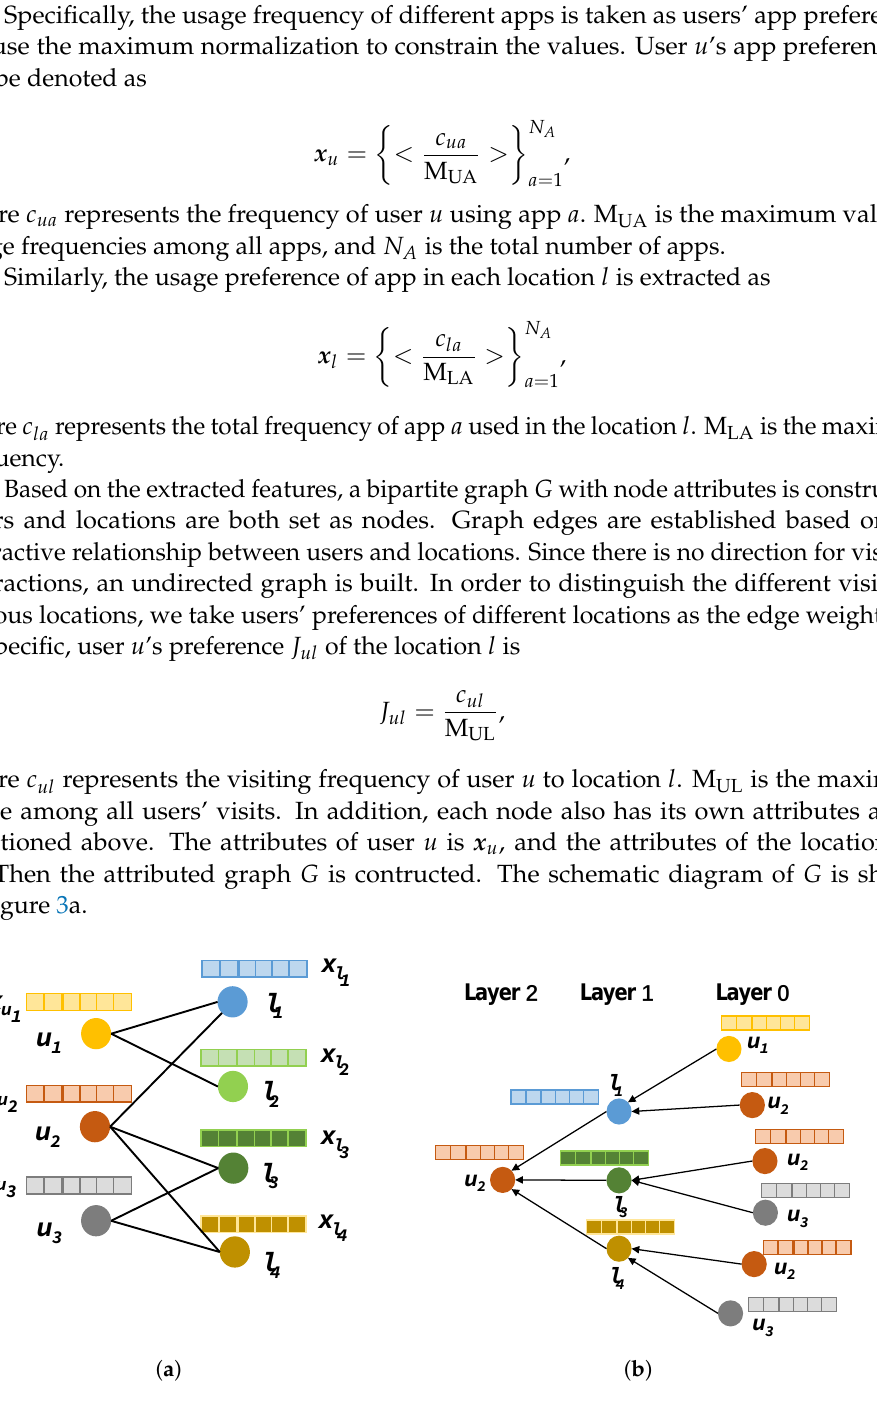
Figure 3. The “User-Location” Bipartite Graph G and the Information Propagation in Graph Convo- lution. ( a ) The Schematic of “User-Location” Bipartite Graph. ( b ) The Information Propagation of Graph